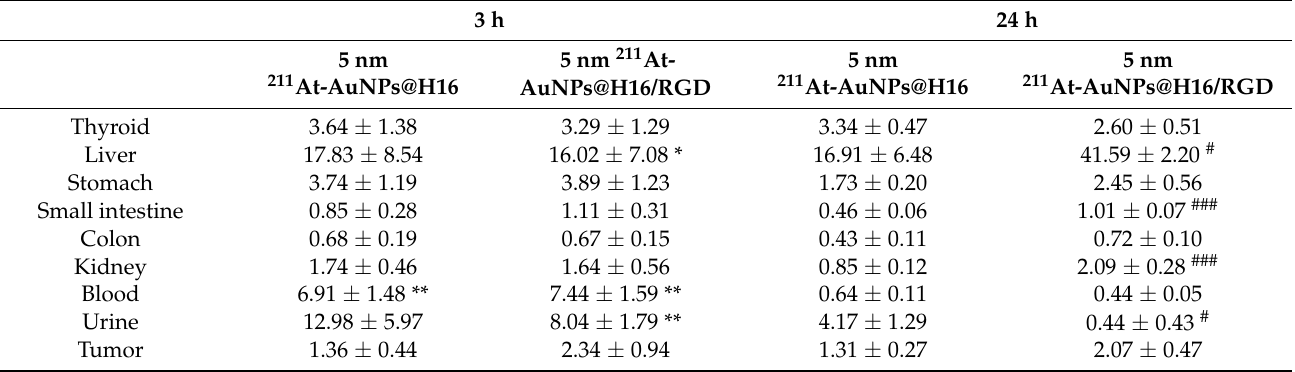
Table 3. Comparison of percentage distribution of injected dose per gram (% ID/g) of 211 At-AuNPs by peptide modification.